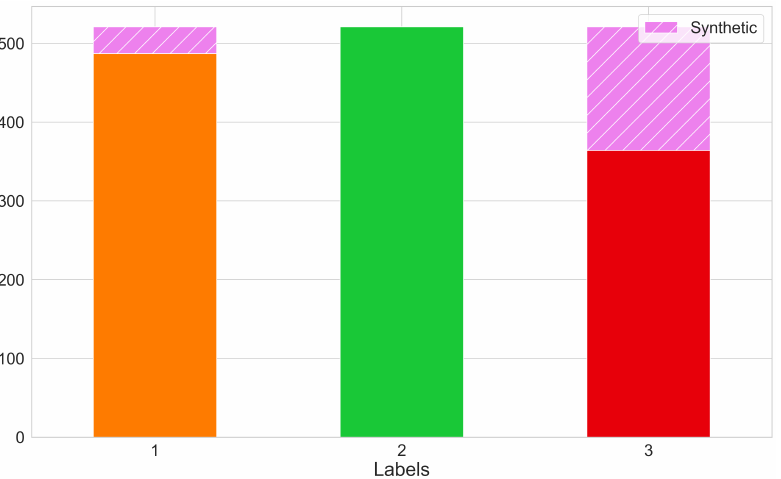
Figure 11. Number of samples per class label after applying the SMOTE